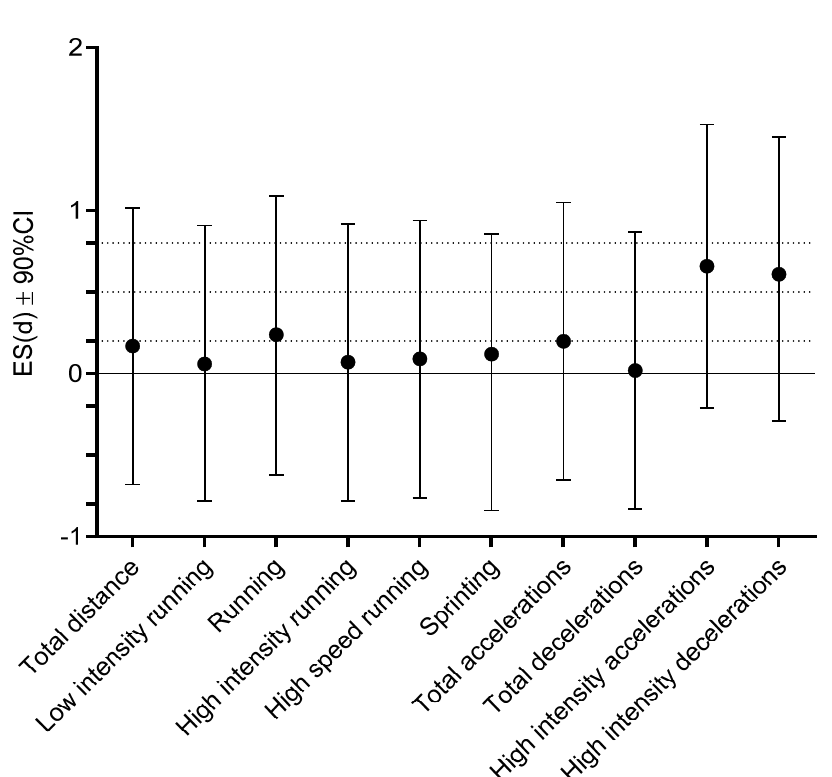
Figure 3. Effect size (ES) differences for match running performance within infected players before being diagnosed for COVID-19 and after return to play (dashed lines present ES ranges: <0.02 = trivial; 0.2–0.6 = small; >0.6–1.2 = moderate; >1.2–2.0 = large; and >2.0 very large differences).